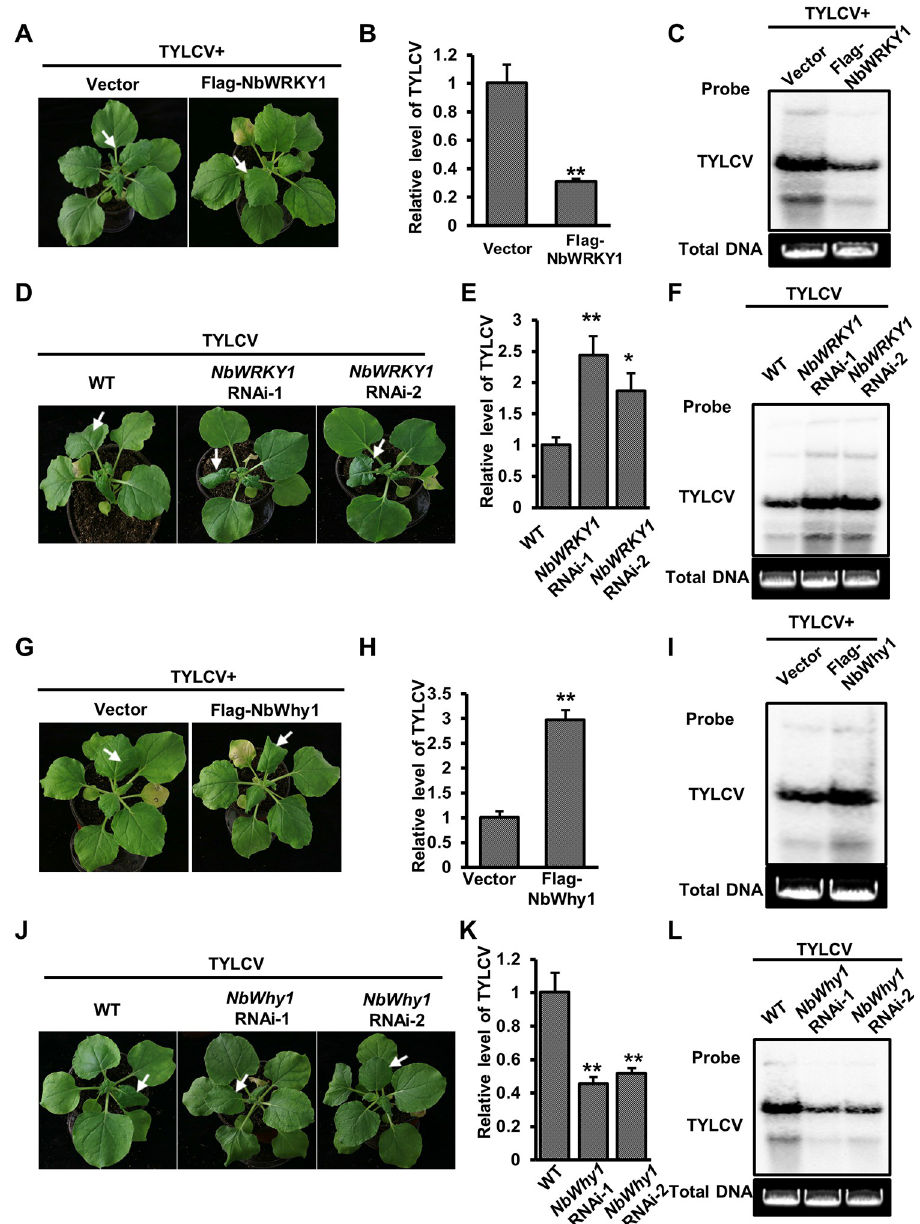
Fig 7. The NbWRKY1-NbWhy1 cassette combats tomato yellow leaf curl virus (TYLCV) infection. . (A) Effect of the transient overexpression of NbWRKY1 on the symptoms induced by TYLCV at 14 dpi. N . benthamiana plants inoculated with TYLCV and pCambia-Flag (the vector control) were used as controls. (B) qPCR analysis of the relative accumulation of TYLCV DNA in the plants shown in (A). (C) Southern blot analysis of viral DNA accumulation in the systemic leaves of the inoculated plants as shown in (A). (D) Symptoms of TYLCV-inoculated wild-type (WT) and NbWRKY1 RNAi N . benthamiana plants at 14 dpi. (E) qPCR analysis of the relative accumulation of TYLCV DNA in the plants shown in (D). (F) Southern blot analysis of viral DNA accumulation in the systemic leaves of the inoculated plants as shown in (D). (G) Effect of the transient overexpression of NbWhy1 on the symptoms induced by TYLCV at 14 dpi. (H) qPCR analysis of the relative accumulation of TYLCV DNA in the plants shown in (G). (I) Southern blot analysis of viral DNA accumulation in the systemic leaves of the inoculated plants as shown in (G). (J) Symptoms of TYLCV-inoculated wild-type (WT) and NbWhy1 RNAi N . benthamiana plants at 14 dpi. (K) qPCR analysis of the relative accumulation of TYLCV DNA in the plants shown in (J). (L) Southern blot analysis of viral DNA accumulation in the systemic leaves of the inoculated plants as shown in (J). White arrows indicate different severity of the corresponding leaves. 25S rRNA was used as an internal control of qPCR. Mean and standard deviation of